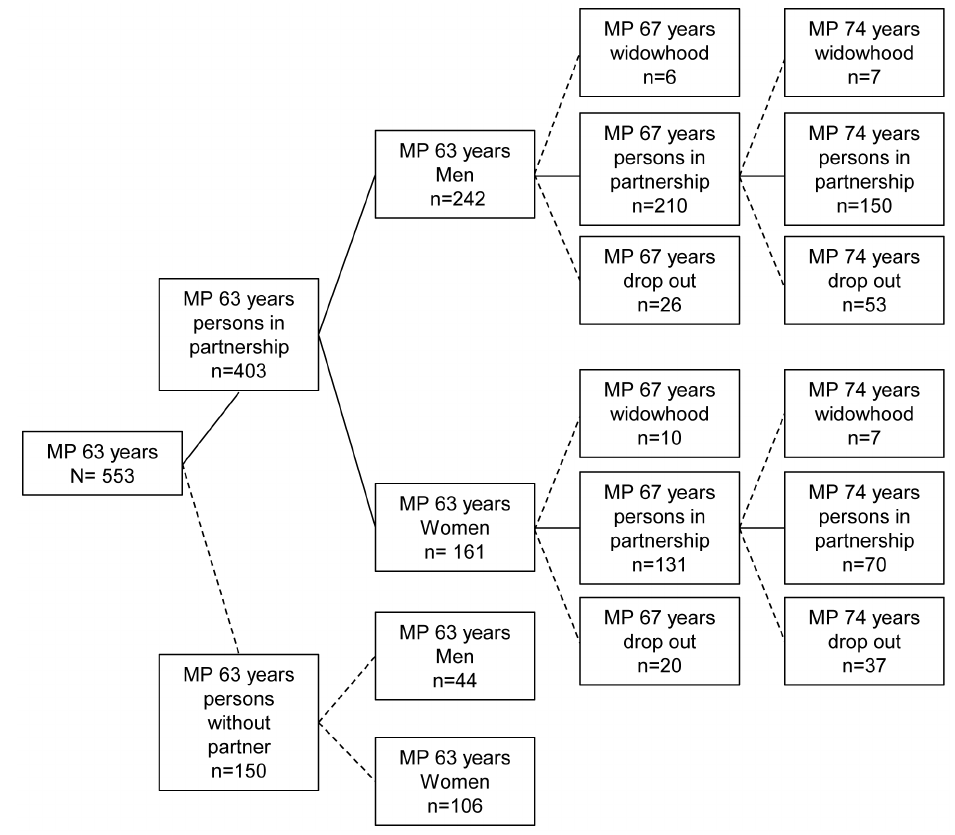
Figure 1. Selection process of the sub-samples at MP 63 years, MP 67 years, and 74 years. Persons who lived in relationship are shown with a solid line. Persons who dropped out or became a widow/widower are shown with a broken line.